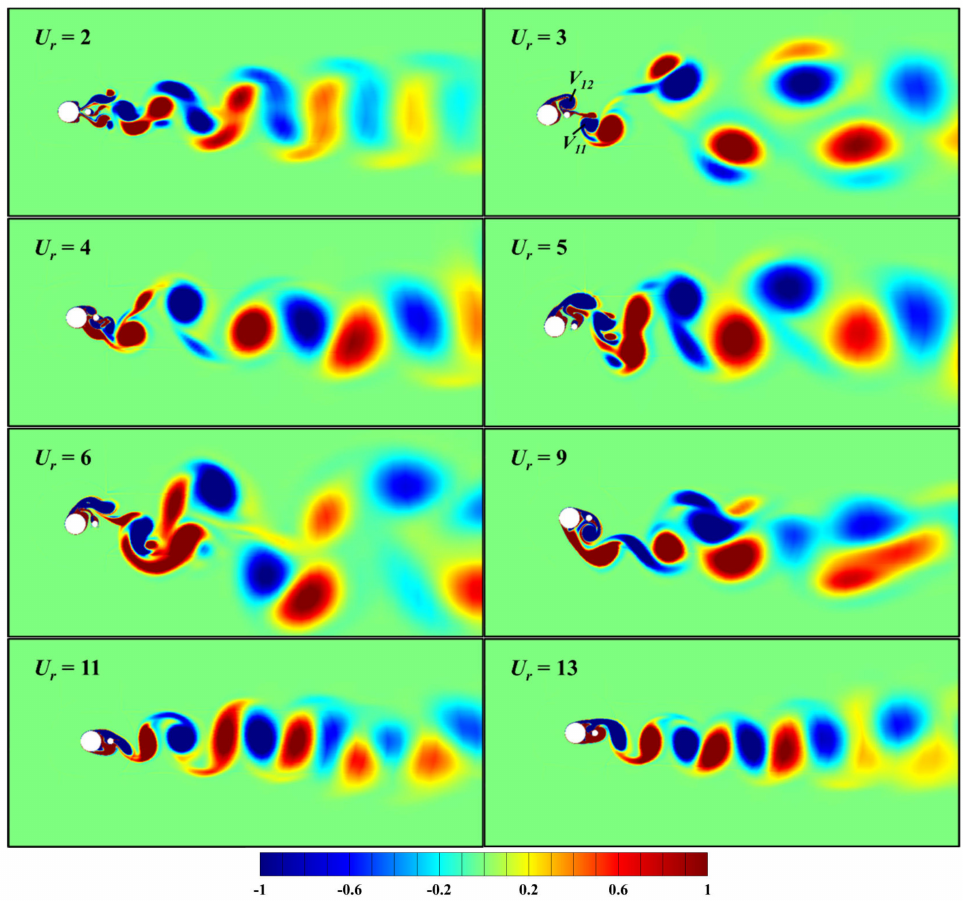
Figure 11. Instantaneous vorticity field for two coupled cylinders at α = 0 ◦ and d/D = 0.3.